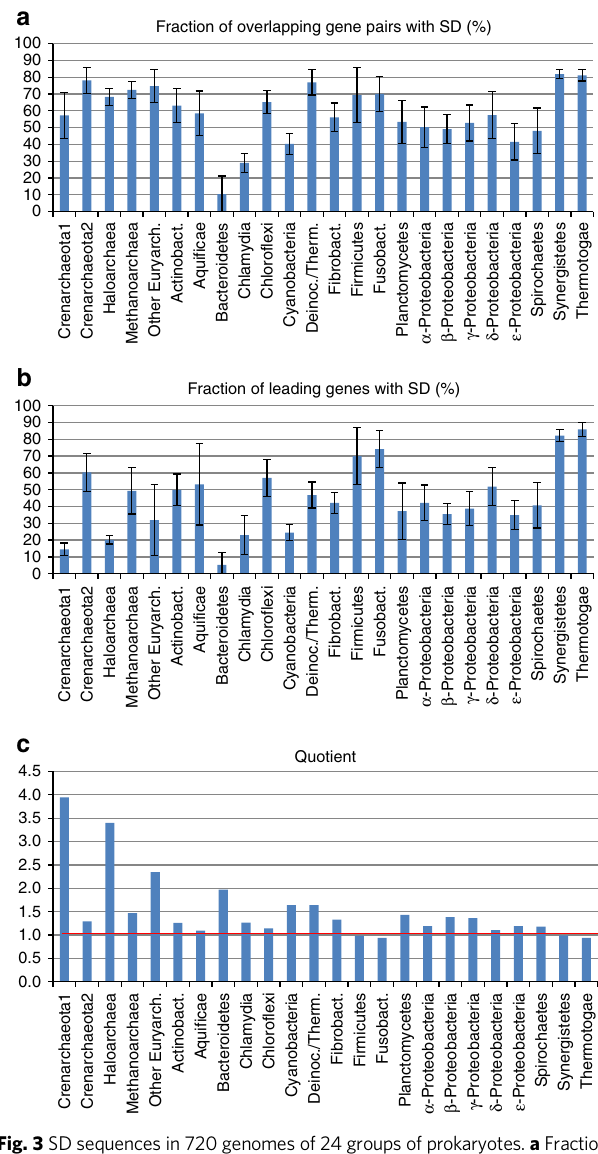
Fig. 3 SD sequences in 720 genomes of 24 groups of prokaryotes. a Fractions of overlapping gene pairs that contain a SD motif upstream of the downstream gene, in the 3 ′ -region of the upstream gene. Mean values and standard deviations are shown. b Fractions of leading genes that are preceded by a SD motif. Mean values and standard deviations are shown. c The quotient of the values shown in a and b , which represents the relative importance of the SD motif at downstream genes of overlapping gene pairs versus leading